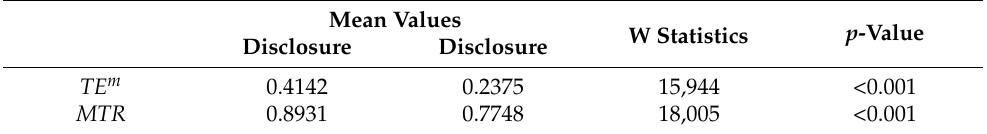
Table 4. Wilcoxon Rank Sum Tests of Disclosure vs.